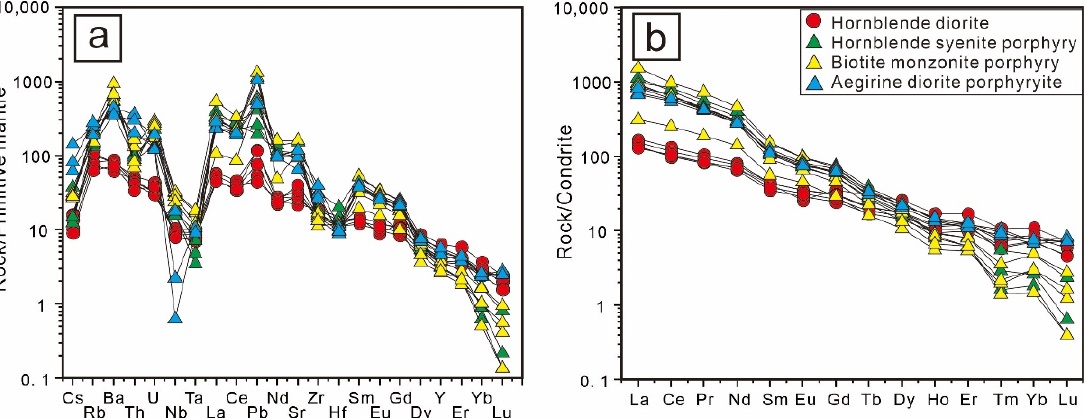
Figure 7. ( a ) Primitive mantle-normalized trace element patterns for the alkaline rocks of the Long- baoshan alkaline complex, modified after [48]. ( b ) Chondrite-normalized REE patterns for the alka- line rocks of the Longbaoshan alkaline complex, with chondrite and PM values from [59].